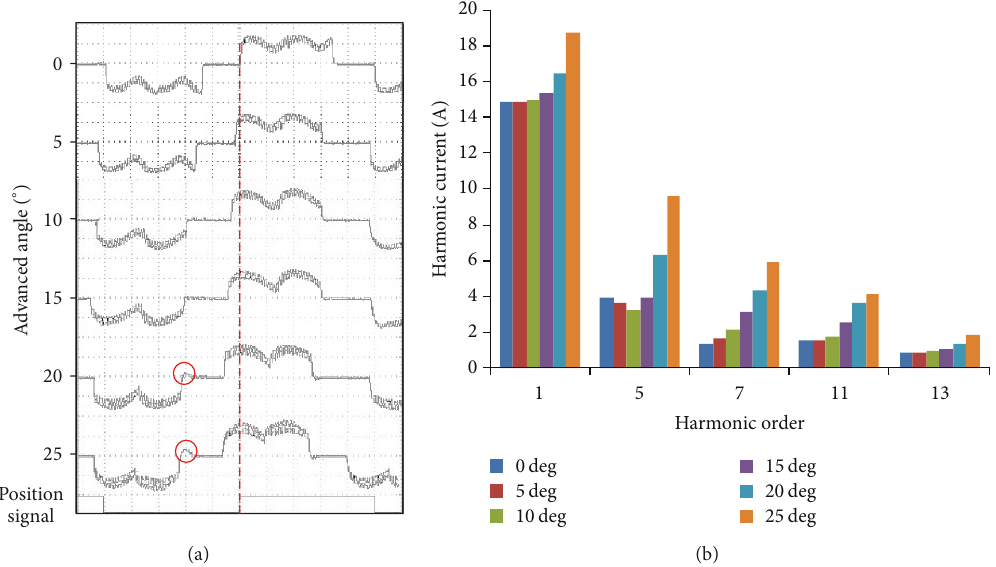
Figure 9: Experimental waveforms in 1500 rpm and 0.8 Nm condition with different advanced angles: (a) phase currents; (b) current harmonics.